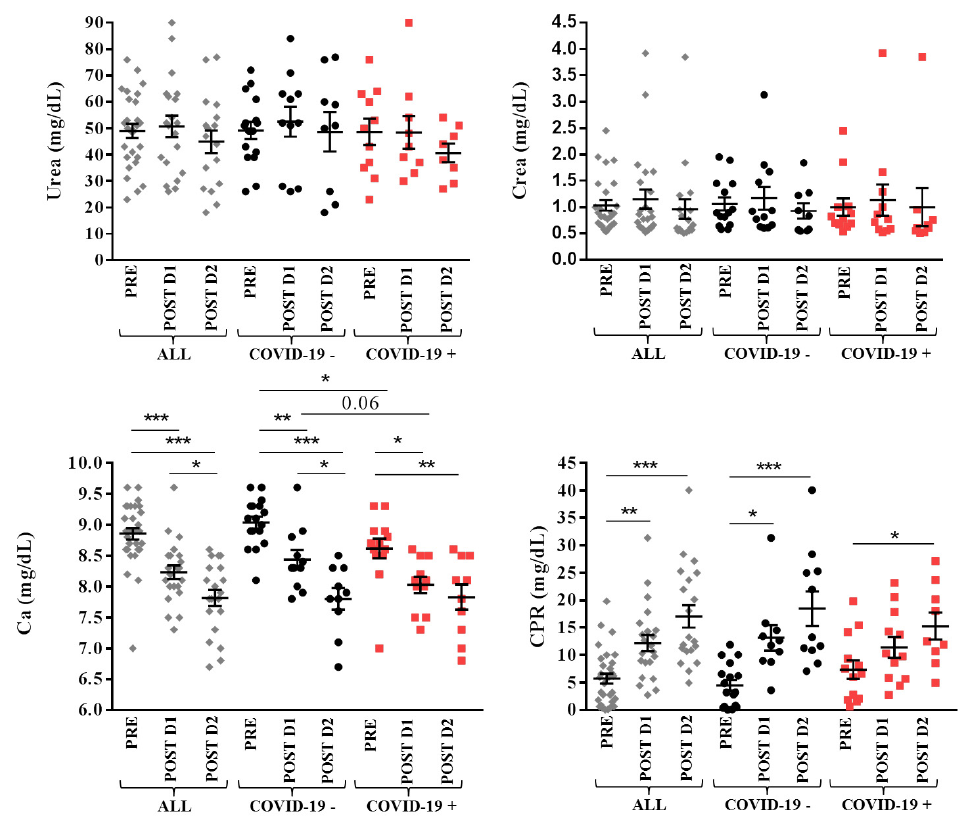
Figure 2. Biochemical parameters in overall (ALL, grey), COVID-19 − (black) and COVID-19 + (red) patients with lower limbs fractures registered pre- (PRE), day 1 (POST D1) and day 2 (POST D2) post-surgery. Mean with SEM are showed. * p ≤ 0.05, ** p < 0.02, *** p < 0.001. Muscular markers creatine phosphokinase (CPK) and aspartate aminotransferase (AST) showed post-surgical increase in COVID-19 − group (112.5 ± 124.4 U/L pre-surgery, 272.6 ± 173.7 U/L day 1 post-surgery, p = 0.002 and 20.1 ± 8.6 U/L pre-surgery, 30.2 ± 24.3 U/L post-surgery, tendency p = 0.09, respectively). For these markers, COVID- 19 + patients showed higher pre-surgical levels which remained high post-surgery (Figure